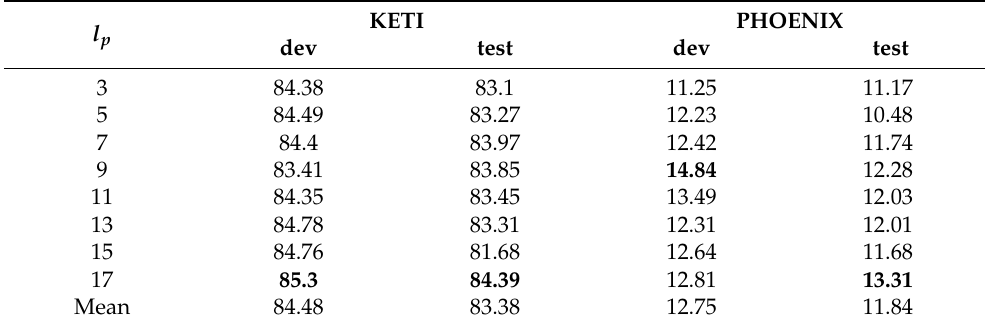
Table 5. BLEU-4 score by l p .